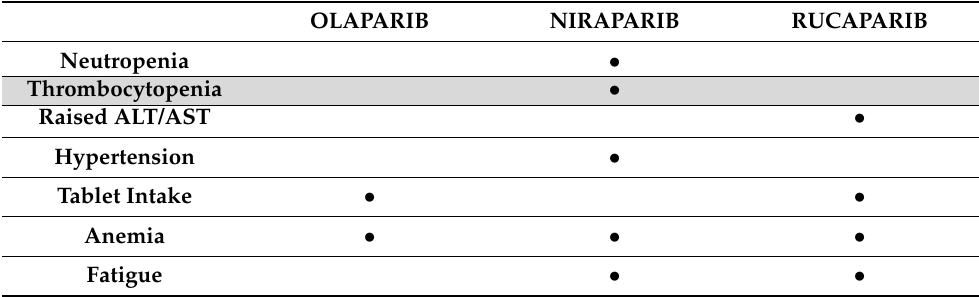
Table 3. Relevant differential toxicities (G3-4) across olaparib, niraparib, and rucaparib.